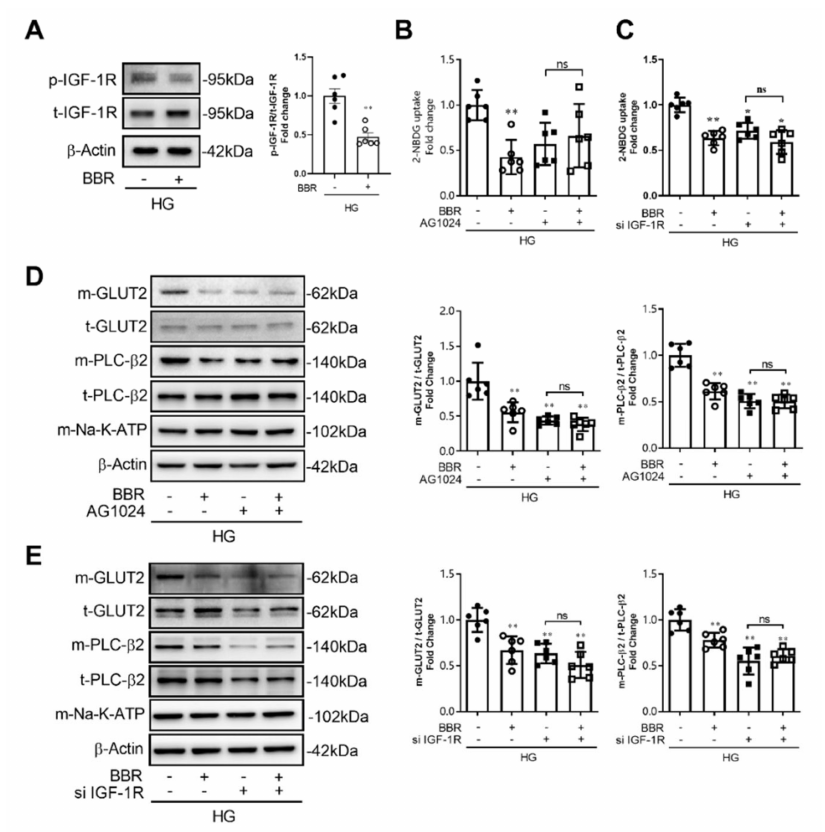
Figure 6. Berberine decreased GLUT2 translocation and glucose uptake through inhibiting the IGF-1R-PLC- β 2-GLUT2 signal pathway. ( A ) Berberine decreased phosphorylation of IGF-1R in IEC-6 cells. ( B , C ) AG1024 (10 µ M) and siRNA for IGF-1R blocked berberine’s effects on 2-NBDG uptake in IEC-6 cells. ( D , E ) AG1024 (10 µ M) and siRNA for IGF-1R blocked berberine’s effects on GLUT2 translocation and PLC- β 2 membrane localization in IEC-6 cells. Data are expressed as mean ± SEM ( n = 6). HG, high concentration of glucose (50 mM); m-GLUT2, membrane localized GLUT2; t-GLUT2, total GLUT2; m-PLC- β 2, membrane localized PLC- β 2; t- PLC- β 2, total PLC- β 2; p-IGF-1R, phosphorylation of IGF-1R; t-IGF-1R, total IGF-1R. AG1024, IGF-1R inhibitor. si IGF-1R, siRNA for IGF-1R. * p < 0.05, ** p < 0.01, vs. control; ns, no